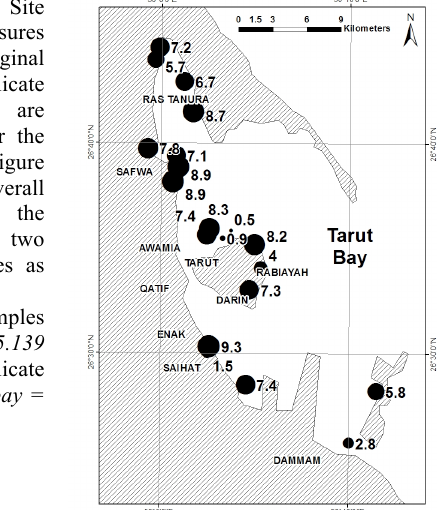
Figure 4: Map of the average site PLI measures for the 20 sites. Size of the circle is proportional to the value of site